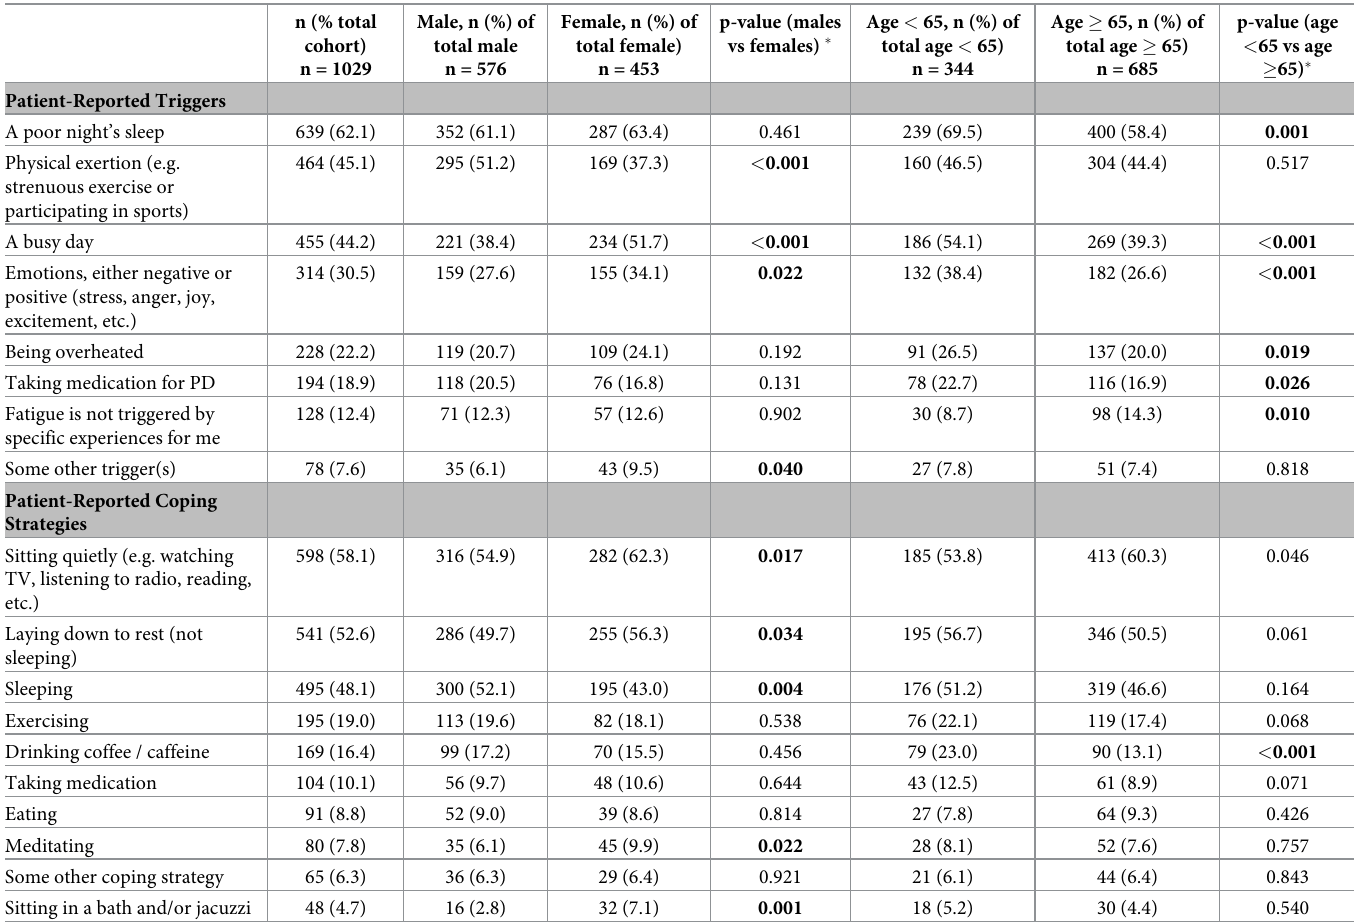
Table 3. Triggers and coping strategies for fatigue reported by cohort as a whole and in demographic